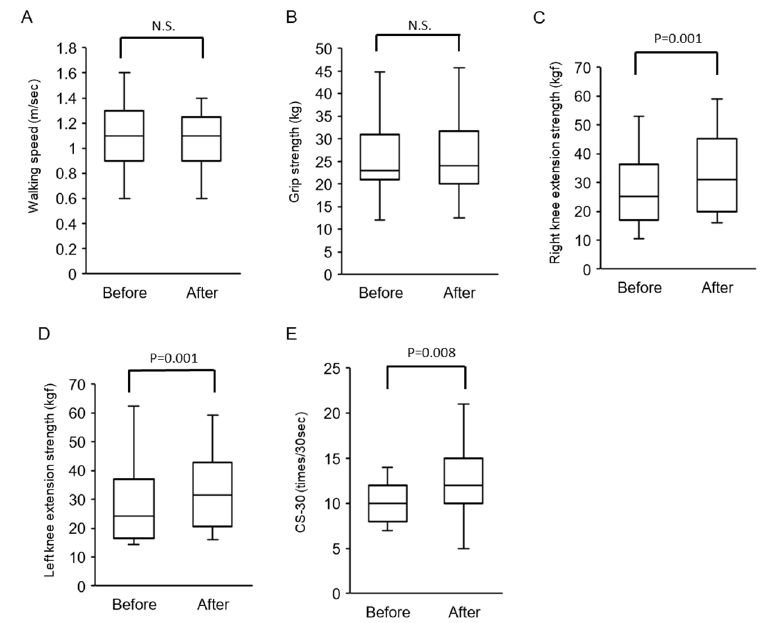
Figure 2. Changes in walking speed and muscle strength after physical therapy. ( A ) Walking speed, ( B ) grip strength, ( C ) right knee extension strength, ( D ) left knee extension strength, and ( E ) CS-30. Abbreviations: N.S.—not significant; CS-30—30-s chair–stand test.